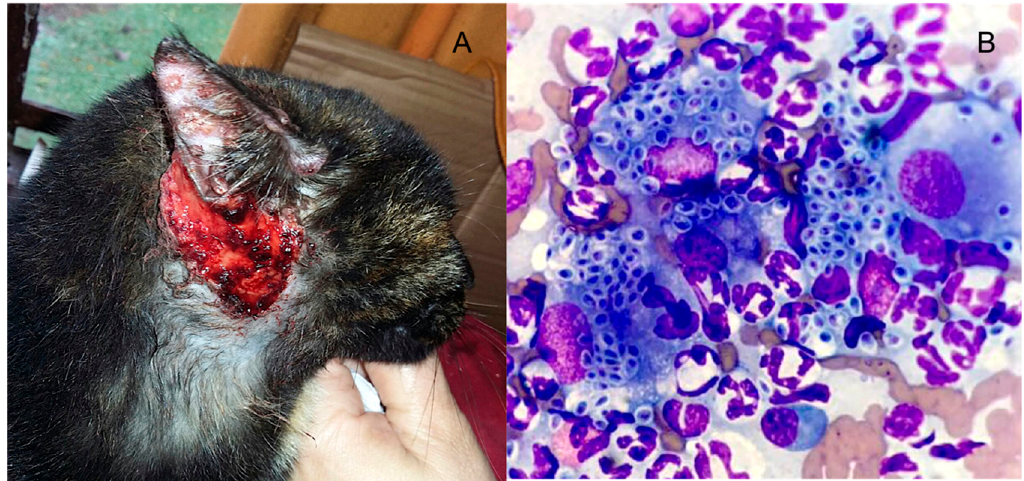
Figure 3. Ulcerated and papular vesicular lesions in the head and ear of a cat with proved Sporothrix brasiliensis infection ( A ). Cutaneous feline lesions are highly infective and harbor a great number of yeast cells of the fungus. Feline sporotrichosis can be easily diagnosed by secretion direct exam stained Giemsa ×1,000 ( B